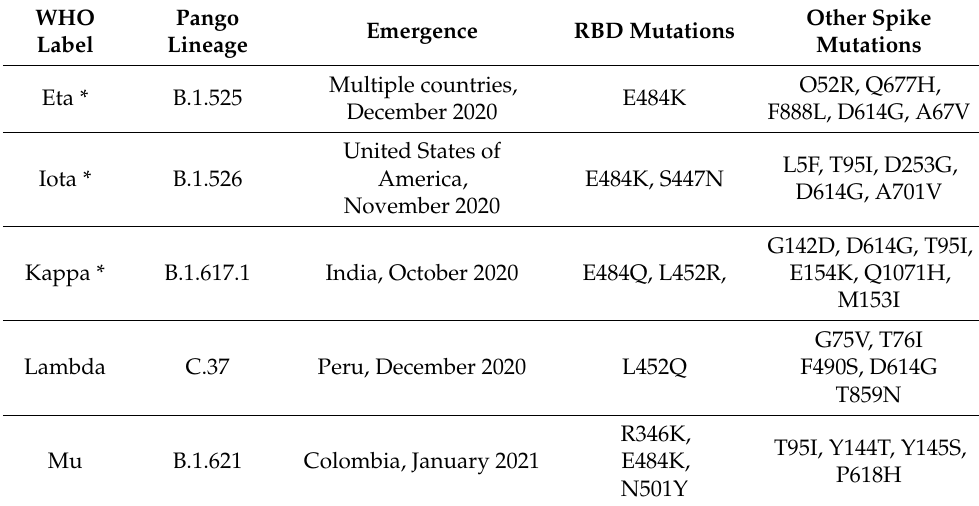
Table 2. Emergence of SARS-CoV-2 variants of interest (VOIs) and mutation in spike glycoprotein of each variant (expasy, CoV lineage,